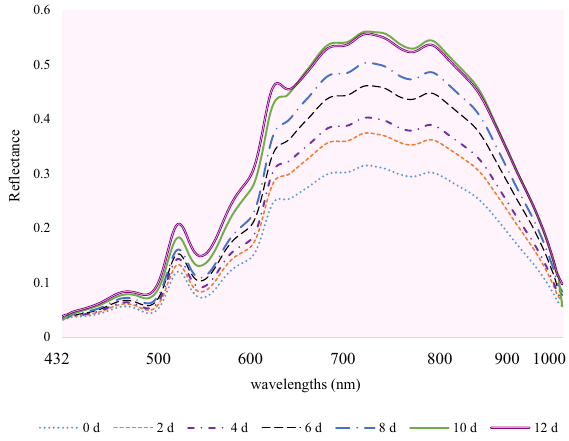
Figure 1. Extracted mean reflectance spectra of rainbow trout fish fillets during cold storage.